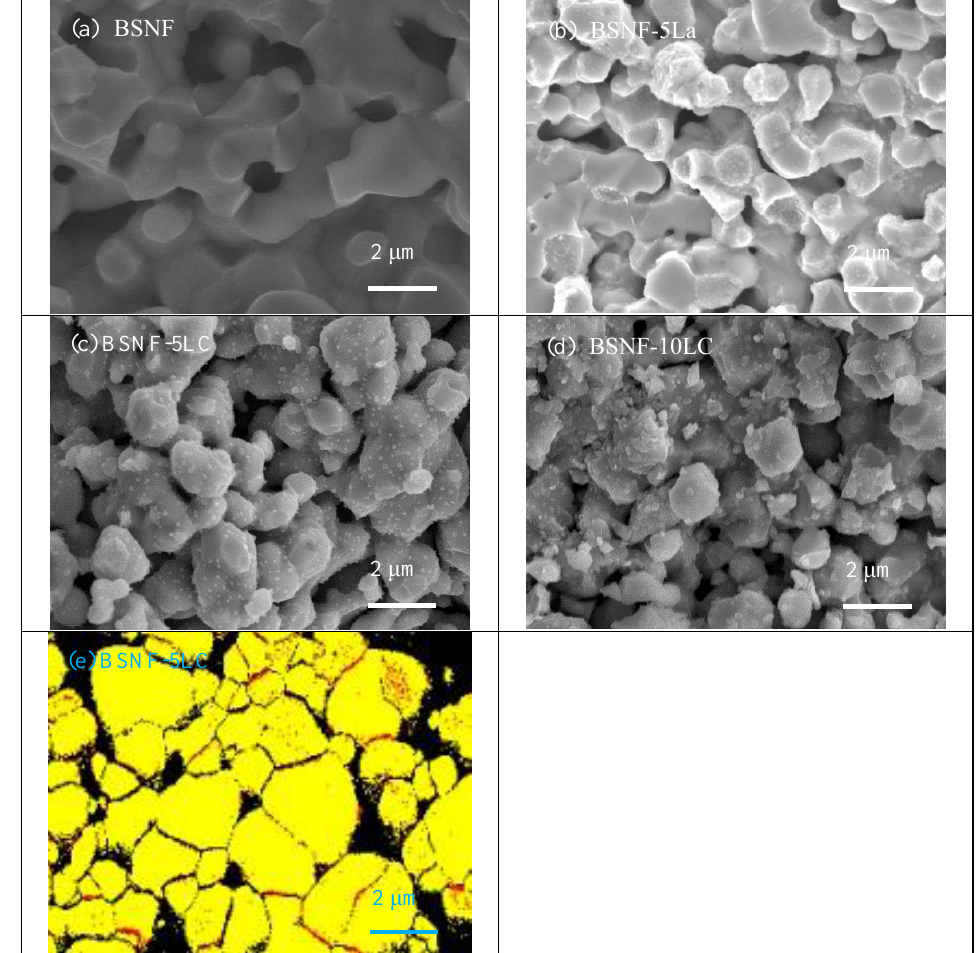
Figure 10. FESEM micrographs of ( a ) BSNF, ( b ) BSNF-5 La, ( c ) BSNF-5 LC and ( d ) BSNF-10 LC sintered at 1150 °C-6 h. EBSD image of ( e ) BSNF-5 LC. Red dots represent LC-species and yellow regions are BSNF grains [72].